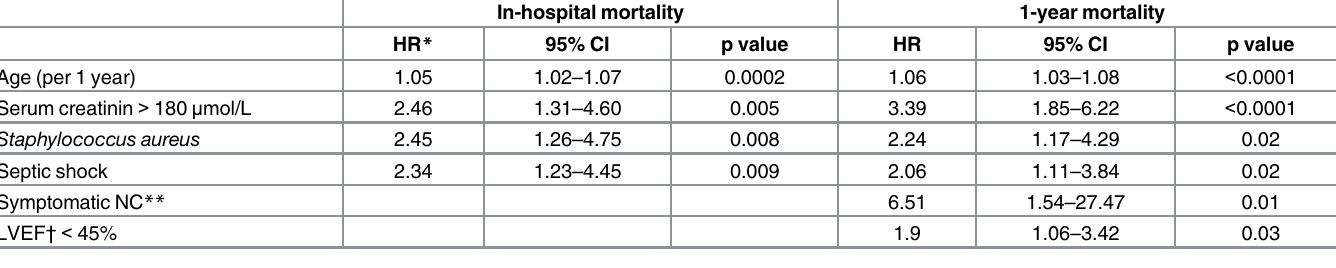
Table 6. Factors associated with in-hospital and 1-year mortality among patients with neurological